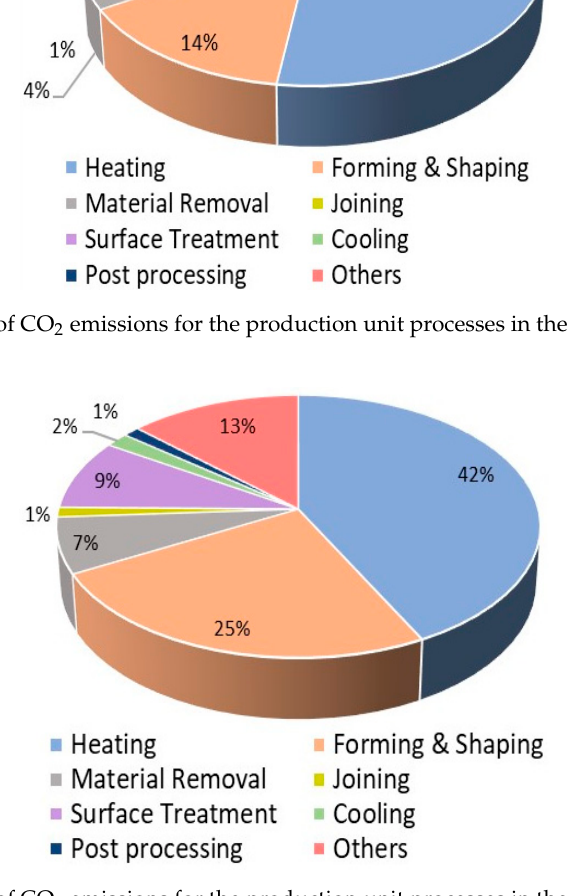
Figure 17. The share of CO 2 emissions for the production unit processes in the Swedish engineering industry (Scenario 2).